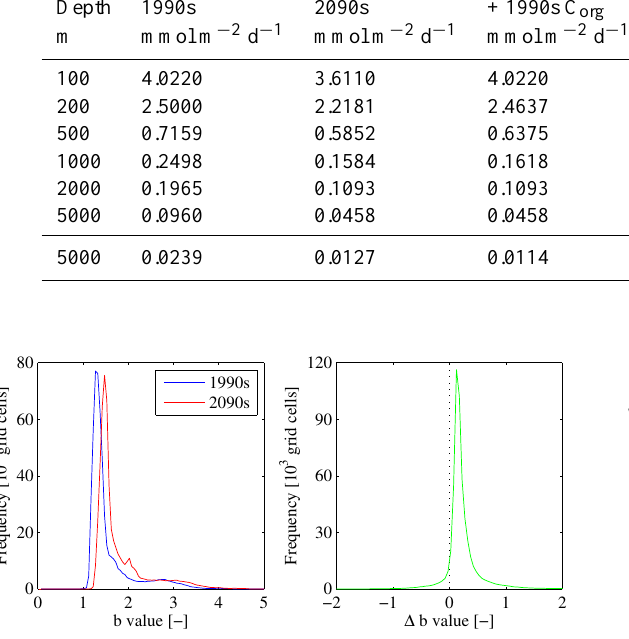
Fig. 23. Frequency distribution of Martin et al. (1987) b parameter values estimated from the 100m and 1000m fluxes of slow- and fast-sinking detritus for the 1990s and 2090s (left), and the distribu- tion of differences between the 2090s and 1990s